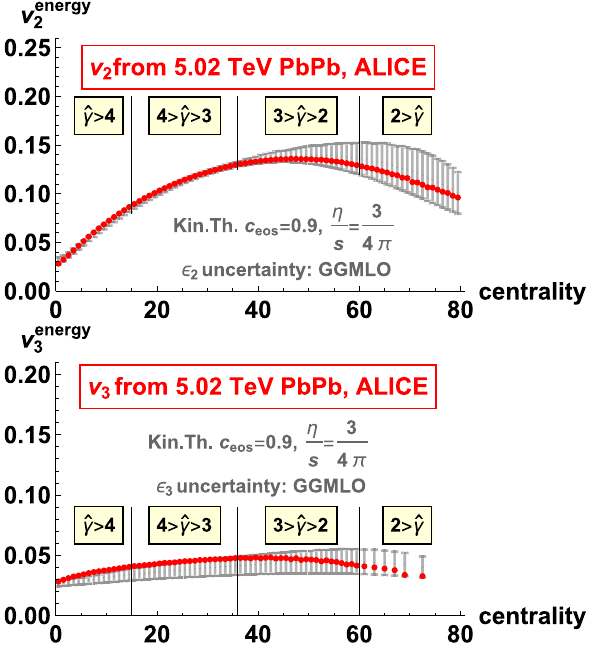
Fig. 13 The energy flows v 2 and v 3 , calculated from kinetic theory according to Eqs. (39),(40) as response to the GGMLO eccentricities plottedinFig.9.CorrectingforaQCD-likeequationofstatewith c eos = 0 . 9, a value η/ s = 3 / 4 π is